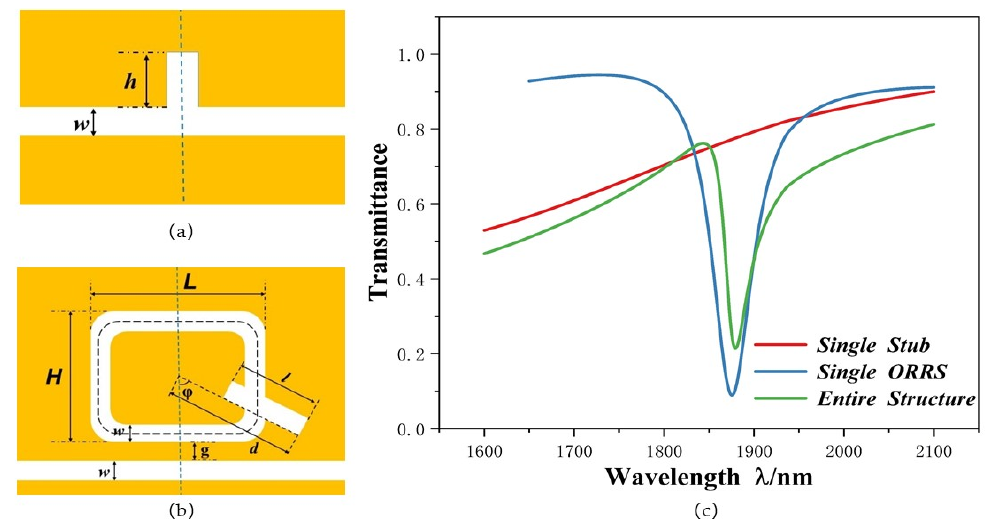
Figure 2. ( a , b ) 2D structure plan diagram of single stub and single ORRS; ( c ) Transmittance spectra of the single stub-1 structure (blue line), single ORRS structure (red line), and entire structure (green line).